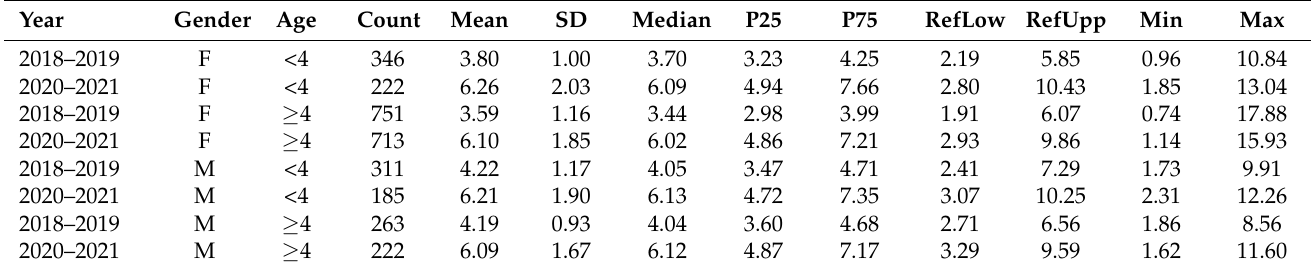
Table 7. Glucose values in rhesus macaques in mmol/L. In 2018–2019, ketamine was used as a sedation protocol, and in 2020–2021, ketamine combined with medetomidine was used as a seda- tion protocol.